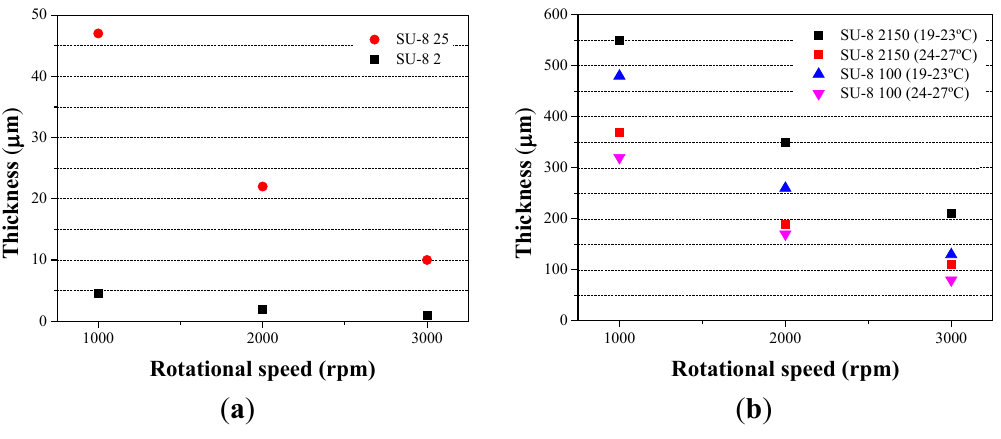
Figure 2. Thicknesses vs. rotational speeds for ( a ) SU-8 2 and SU-8 25; ( b ) SU-8 100 and SU-8 2150, for two ranges of room temperatures.